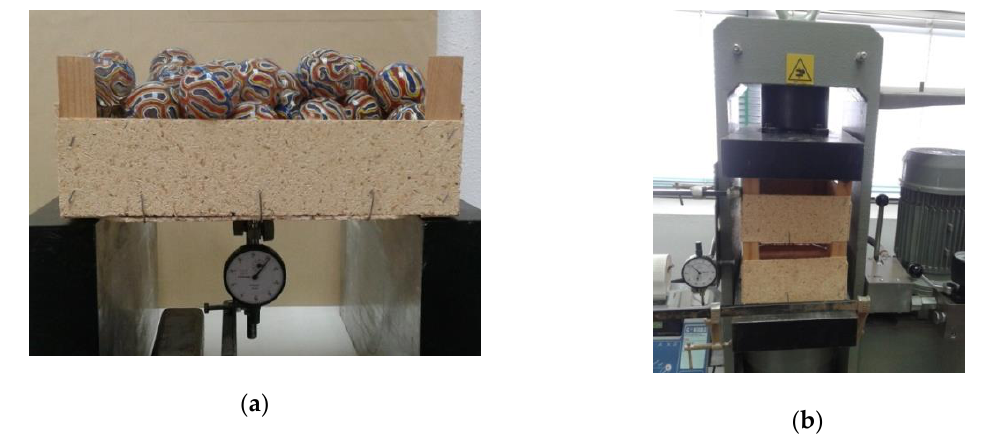
Figure 4. ( a ) Flexural strength test of the container’s base; ( b ) stacking test. Table 5. Stacking test results.